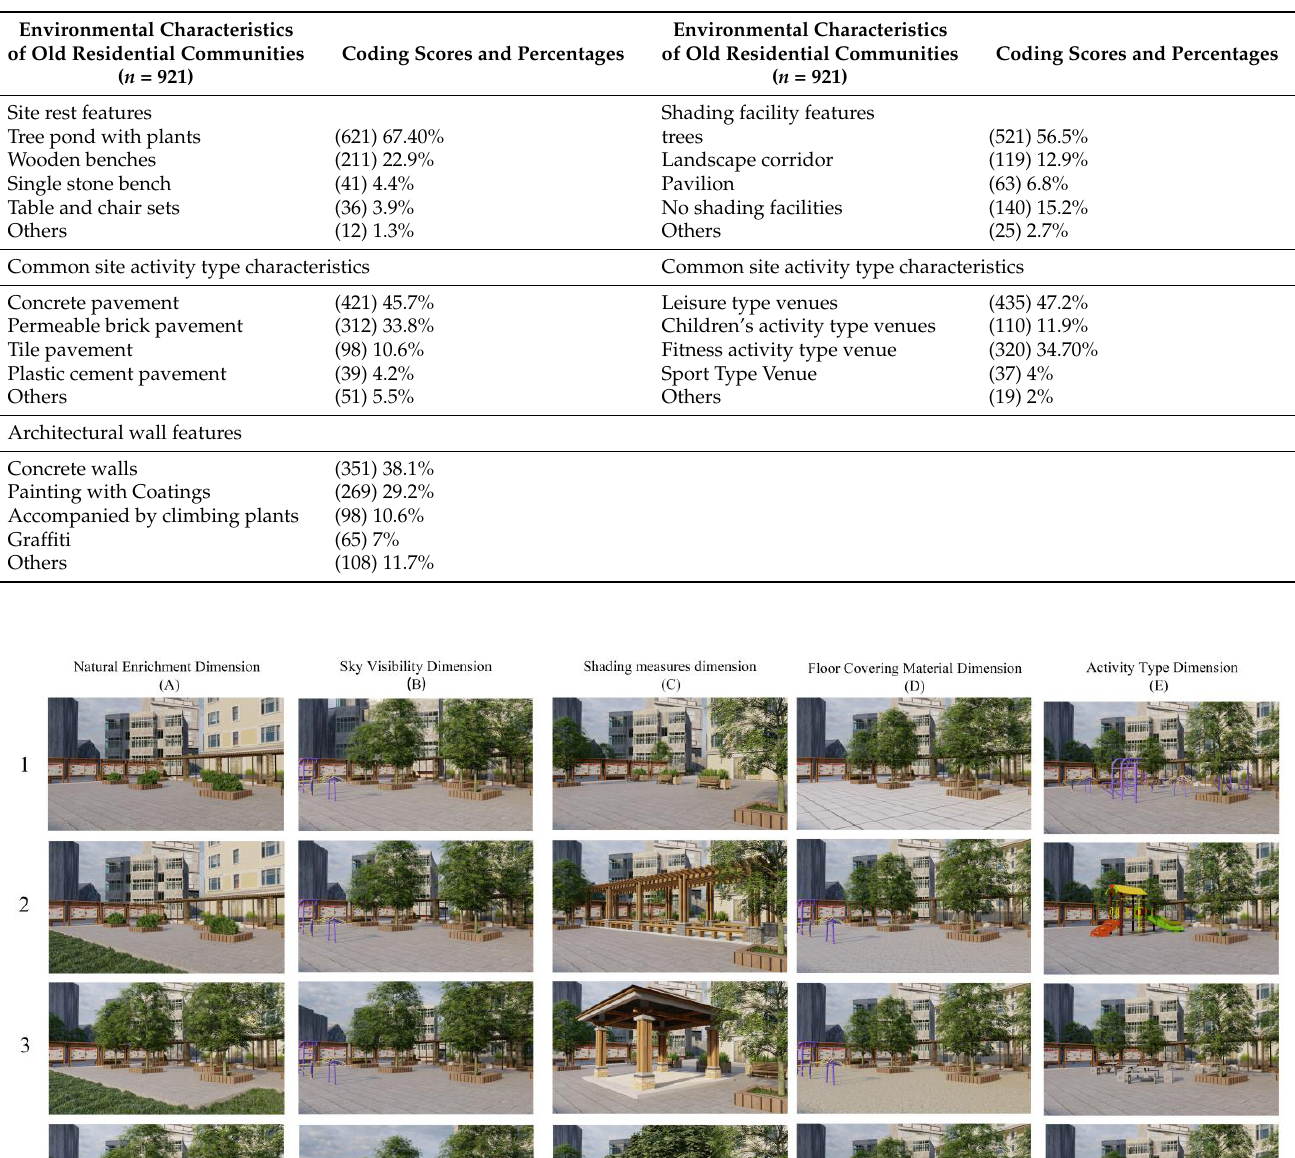
Table 1. Summary table of the proportional distribution of community public space feature codes.